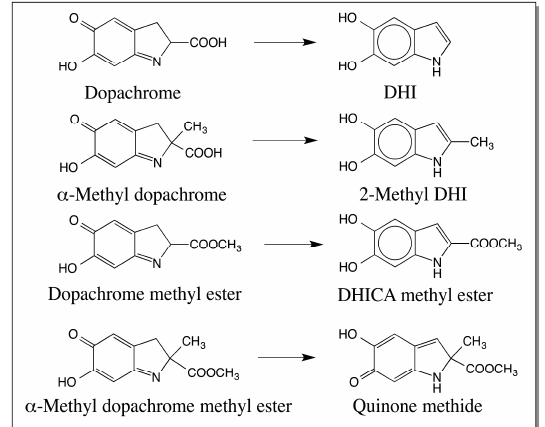
Figure 2. Reactions catalyzed by insect dopachrome conversion factor. Insect dopachrome conversion factor catalyzes decarboxylative rearrangement of dopachrome to DHI. It also accepts α -methyl dopachrome as the substrate and produces 2-methyl DHI as the sole product. If dopachrome methyl ester is provided as the substrate, it uniquely converts it to DHICA methyl ester, thus acting as a typical tautomerase. Finally with α -methyl dopachrome methyl ester, which can neither undergo decarboxylation nor deprotonation at α -carbon atom, the enzyme causes an isomerization producing the stable quinone